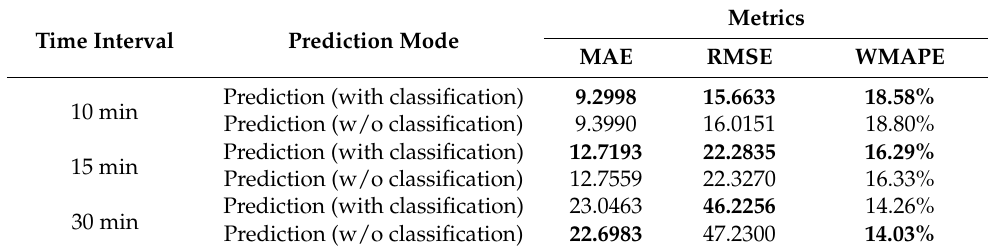
Table 9. Prediction results in the Xiamen